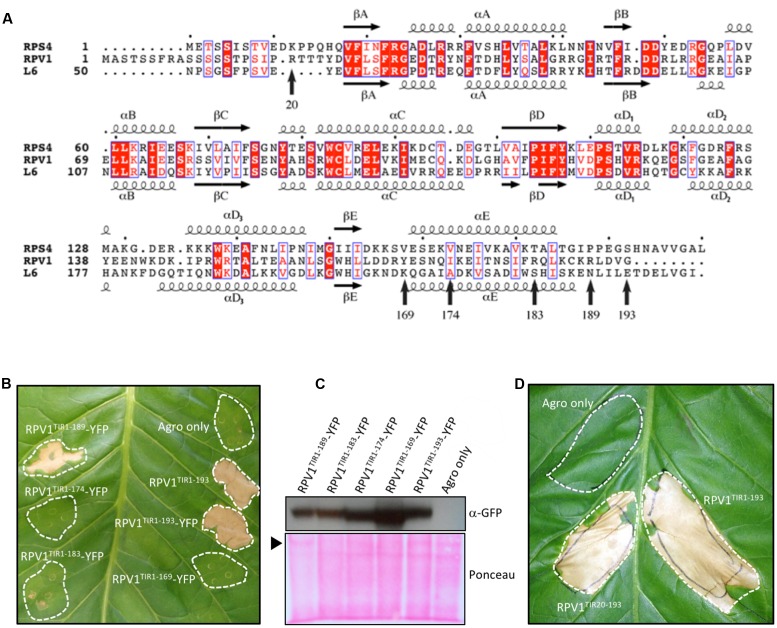
RPV1TIR cell-death signaling.
(A) Multiple sequence alignment containing RPS4 (residues 1–193), RPV1 (1–193) and L6 (50–240). The alignment was formatted using the program ESPript (Robert and Gouet, 2014). The secondary structure shown above and below the alignment is derived from the RPS4TIR (PDB ID 4c6r) and L6TIR (PDB ID 3ozi) structures, respectively. Arrows indicate residue positions corresponding to the various RPV1 constructs tested in (B,D). (B,D)
Nicotiana tabacum leaves 5 days after infiltration with A. tumefaciens alone or A. tumefaciens expressing RPV1TIR constructs. (B) Comparison of the RPV1TIR truncations fused to YFP. (C) Protein extracts of tobacco-leaf tissue (B), sampled from agroinfiltrated areas 2 days after agroinfiltration, were immunoblotted with anti-GFP antibodies, demonstrating RPV1TIR-YFP protein expression. The arrow indicates Ponceau staining of the large RuBisCO subunit. (D) Autoactivity is observed with both RPV1TIR1-193 and RPV1TIR20-193 constructs without YFP. Agro only, corresponds to agrobacterium transformed with a vector without an insert.